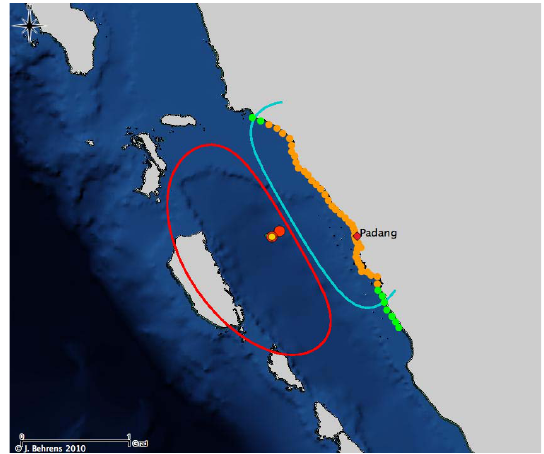
Fig. 17. Result of the selection after 9min (data set 4), analogous to Fig. 14. Due to the over-estimated seismic magnitude, the warning level derived from the matched scenario over-estimates the potential